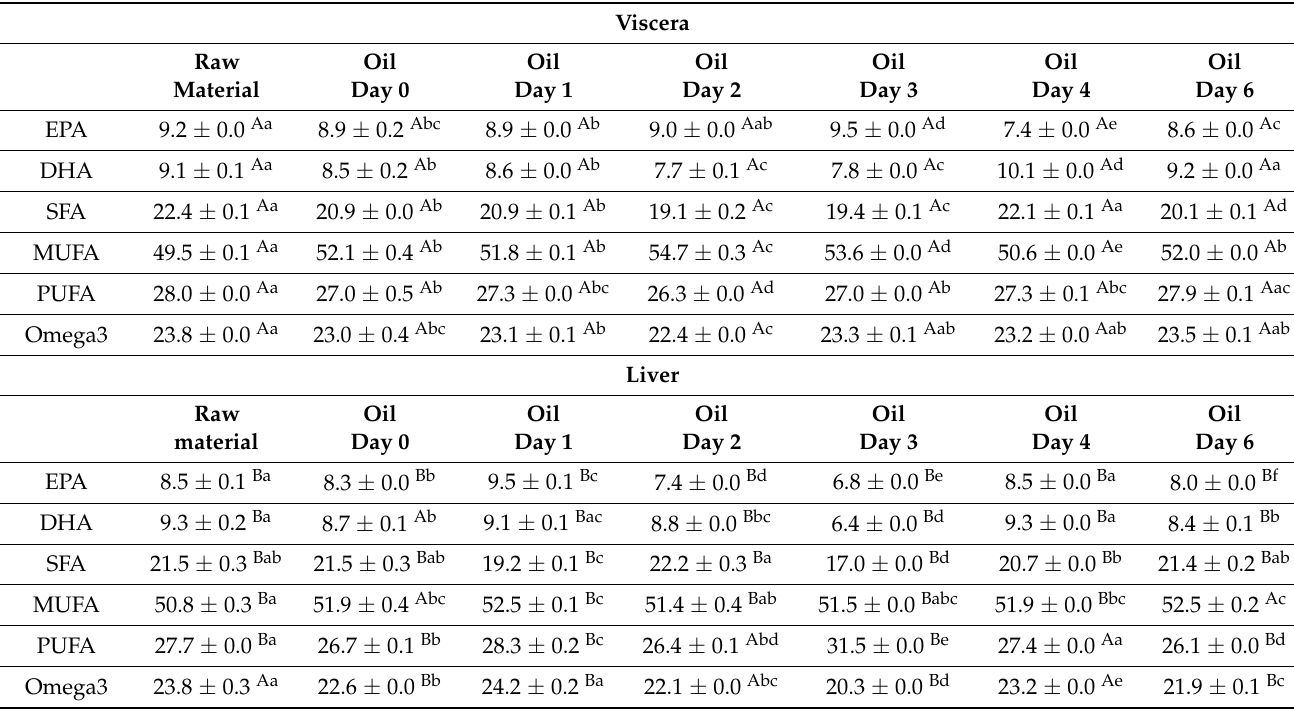
Table 2. Fatty acid composition (% of total fatty acids, mean ± SD) in raw material of viscera and liver and in oil produced after different days of